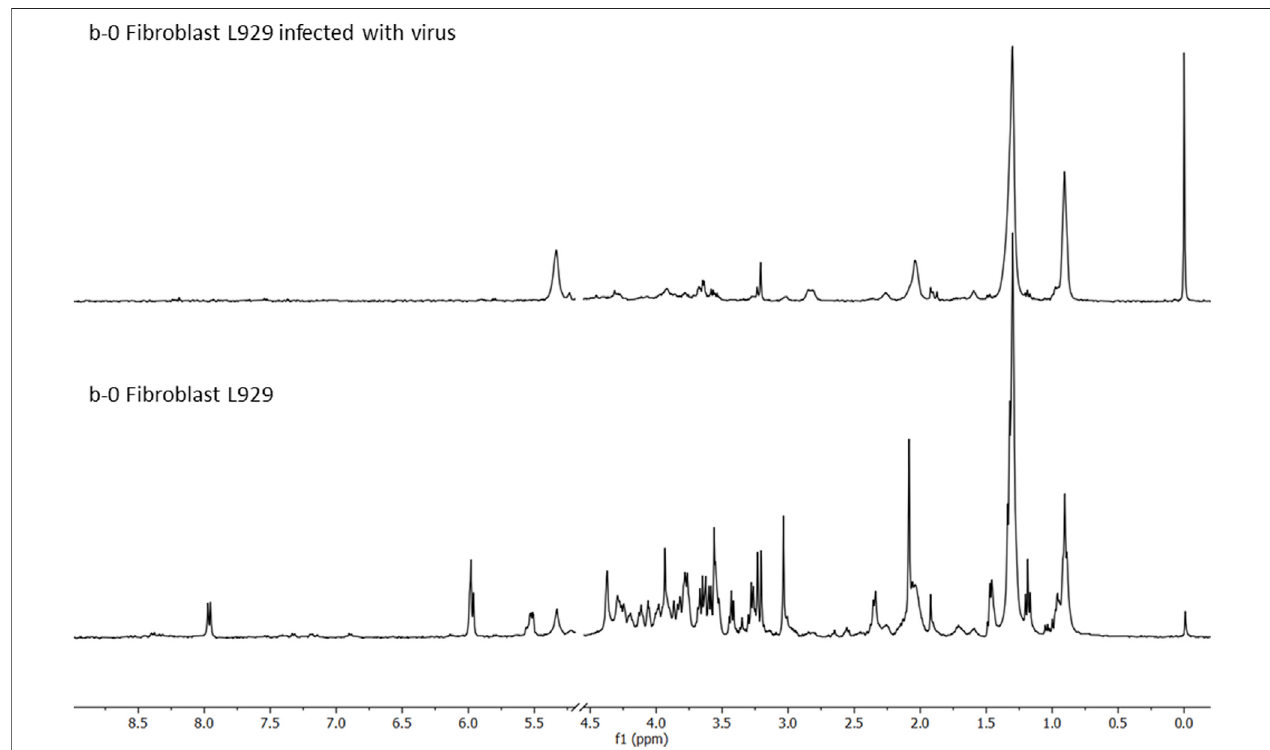
FIGURE 3 | 1 H-NMR CMPG HR-MAS spectra of the fi broblast cells infected with the virus (MHV-3 — upper panel, b-0 Fibroblast L929 infected with the virus), and the healthy fi broblast cells (b-0 Fibroblast L929), acquired using Bruker AVANCE III 400 MHz at 25 ° C, from 0.5 to 9.0 ppm (with the exclusion of HDO, 4.8